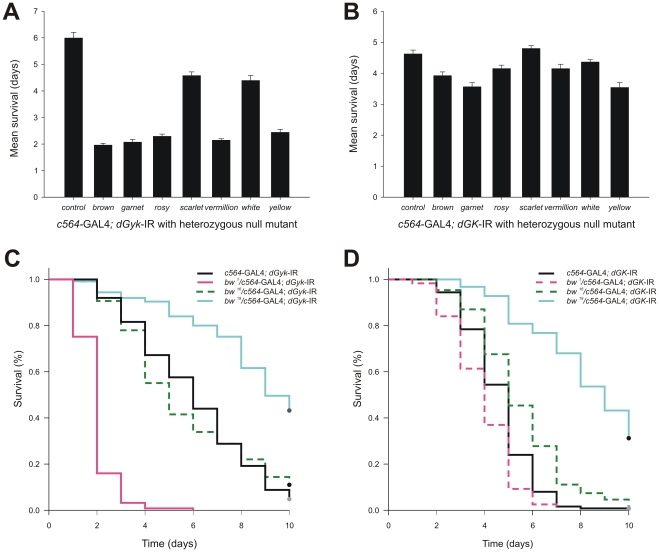
Glycerol hypersensitivity is affected by eye pigmentation null mutations.Flies heterozygous for eye pigmentation null mutations in trans to c564-GAL4 driver and RNAi construct were found to show enhanced glycerol hypersensitivity. Mean survival times are shown for A) dGyk-IR progeny and B) dGK-IR progeny. RNAi progeny from Canton-S flies were used as wild type. Progeny from yellow mutant flies were included as a control for desiccation sensitive flies. Additional glycerol hypersensitive survival assays were performed using flies heterozygous for 3 brown mutations (bw1, bw16, and bw19) in trans to C) c564-GAL4; dGyk-IR and D) c564-GAL4; dGK-IR. These results show that glycerol hypersensitivity can be either enhanced (bw
1) or suppressed (bw
19), suggesting the brown locus to be an important genetic modifier of glycerol hypersensitivity. Glycerol hypersensitive survivorship assays used 6–10 day old female flies, n>100 (see methods for assay conditions). Survivorship curves were analyzed using a Log-rank test on the Kaplan and Meier data. Control data is shown in Figures S6 and S7.